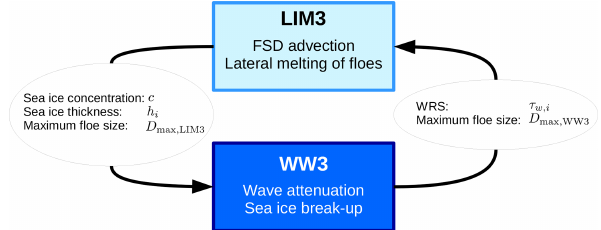
Figure 2. Schematic summary of the exchanged information be- tween the sea ice model LIM3 and the wave model WAVEWATCH III ® in our coupled framework. The two boxes correspond to the processes accounted for in a given model, while the variables ex- changed between the models are listed in the